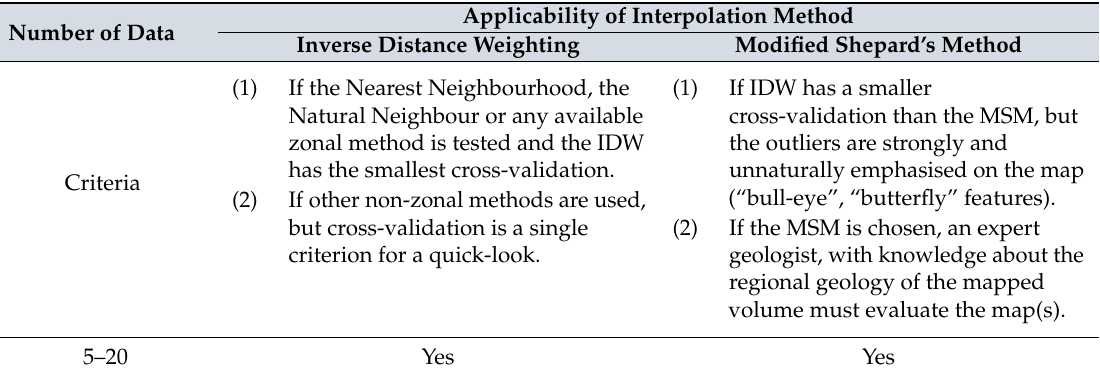
Table 5. Recommended choice between the IDW and MSM methods for a small input data set (less than 20 points of